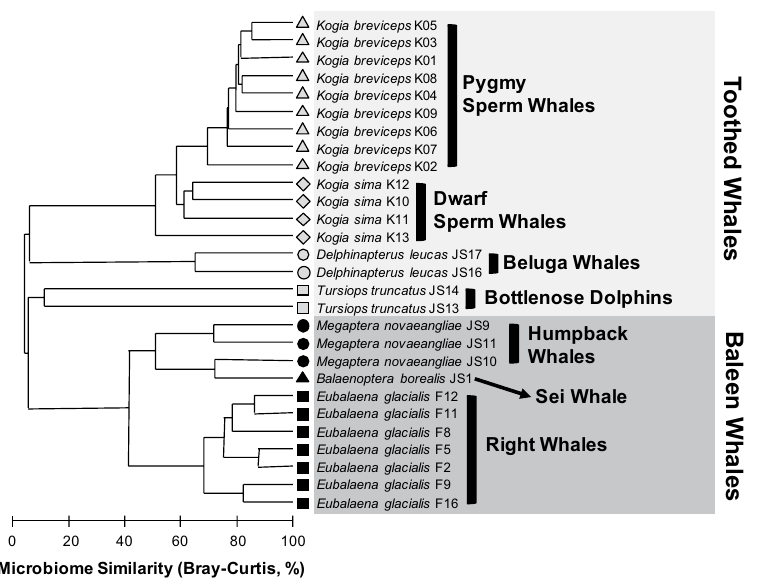
Figure 3. Similarity of gut microbiomes in Kogia breviceps and K . sima compared with previous data from other toothed and baleen whales 25 based on relative abundance OTU data. Shaded boxes delineate toothed whale species ( light gray ) and baleen whale species ( dark gray